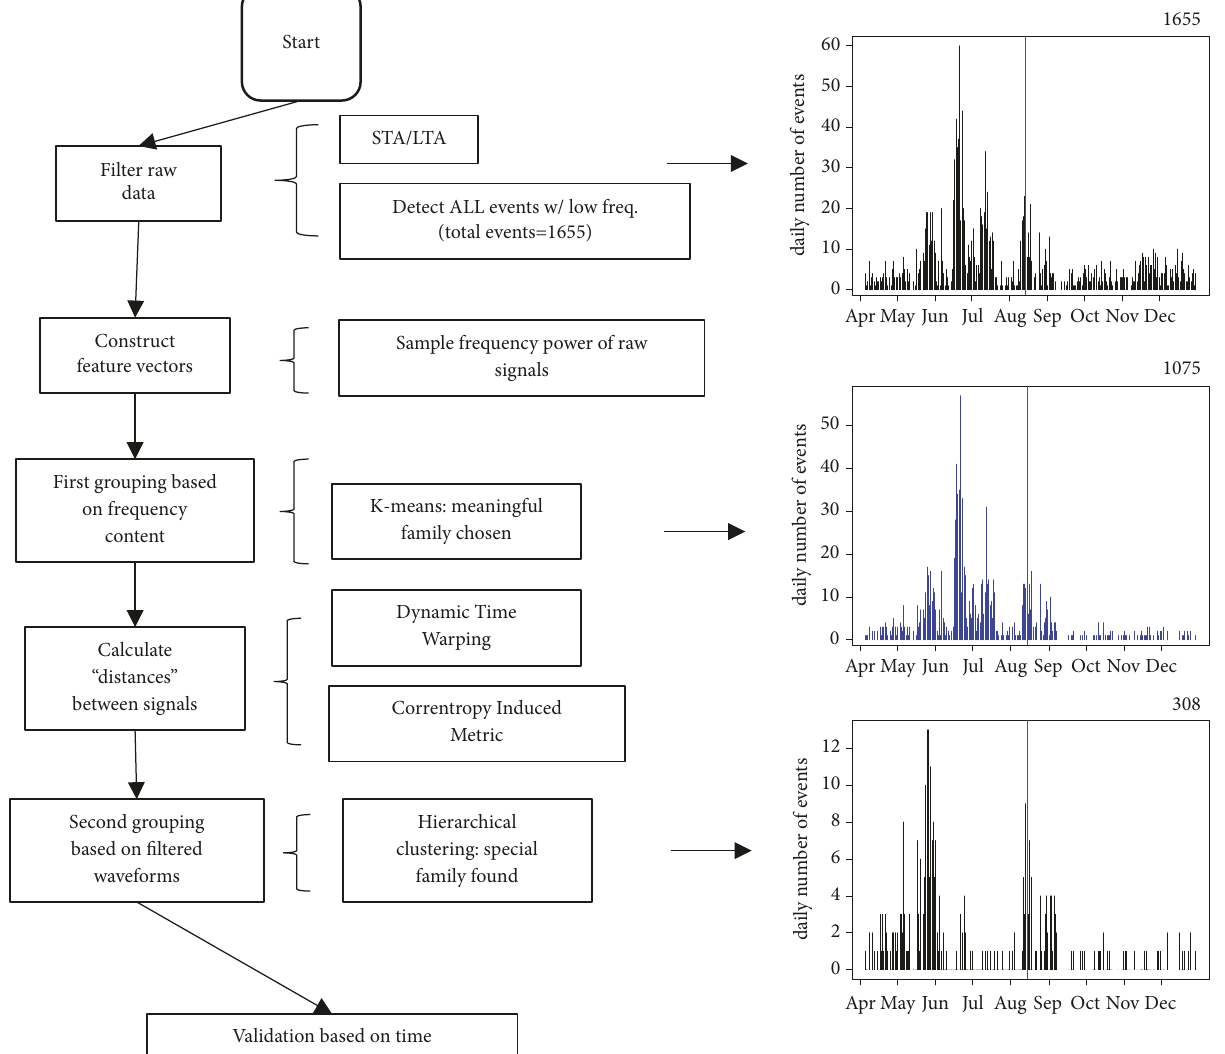
Figure 1: Diagram of the processing and event daily distributions after each